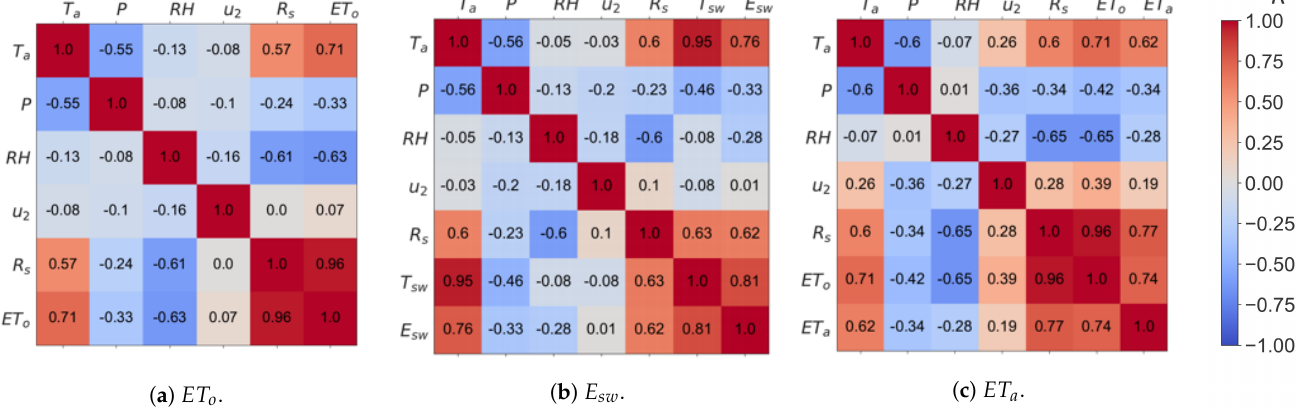
Figure A6. Correlation map between daily climatic variables and ( a ) the reference evapotranspiration at the NDR site, ( b ) lake evaporation at Ingram Lake, and ( c ) and actual evapotranspiration at the CBS